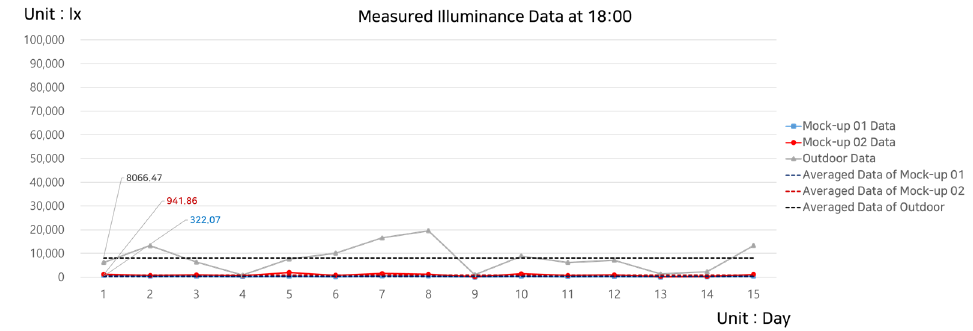
Figure 8. Measured illuminance data in summer season.